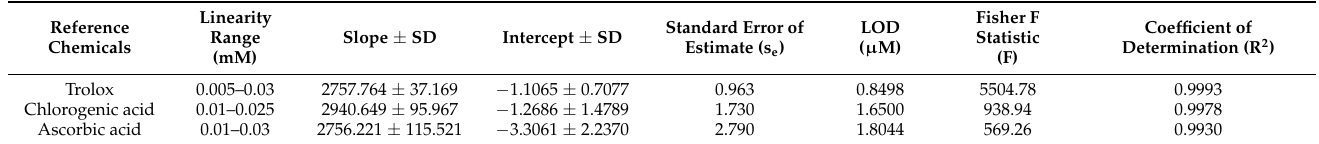
Table 3. Linear regression parameters for the calibration curves representing the percentage of 0.1 mM DPPH absorbance inhibition vs. concentration (mM) of reference chemicals measured at 517 nm. Reference